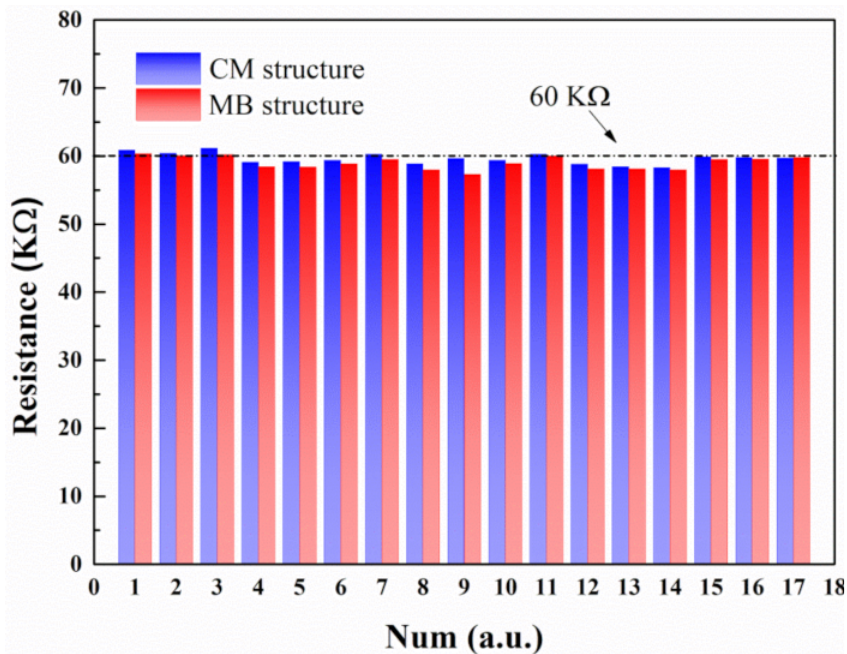
Figure 5. Measured resistances of 34 thermopile